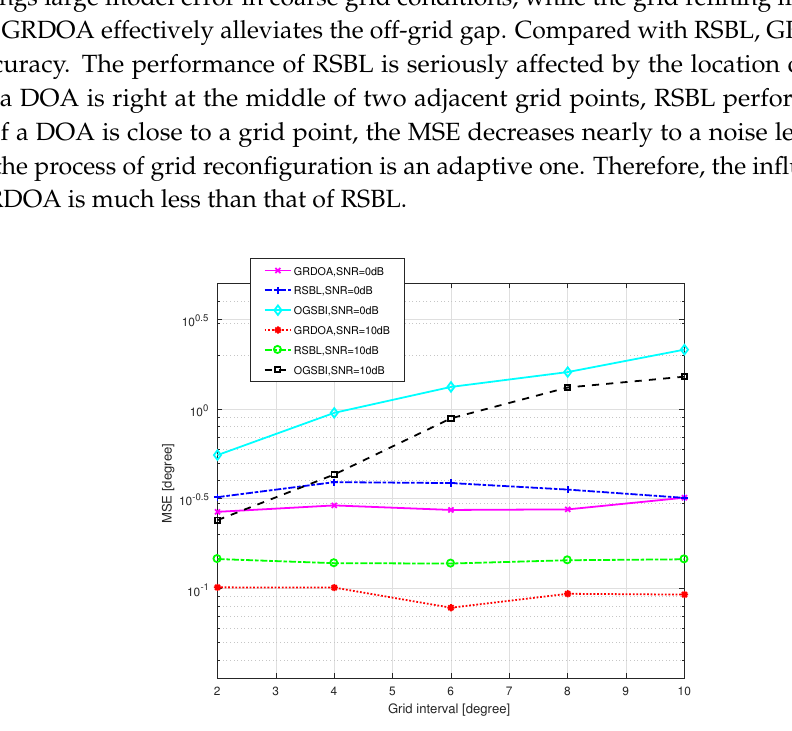
Figure 6. MSE of DOA estimation versus grid interval.